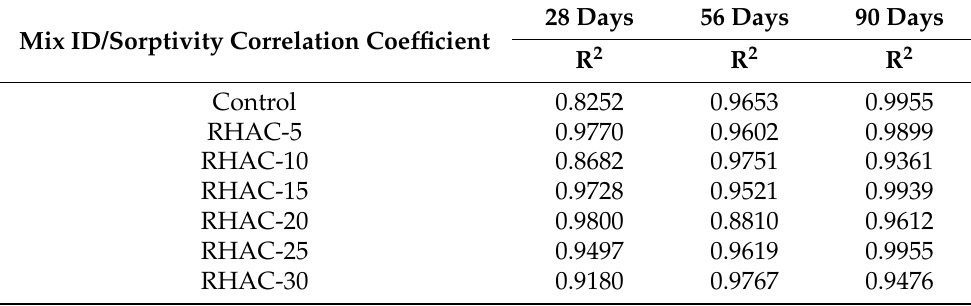
Table 6. Summary for sorptivity correlation coefficient of RHA blended